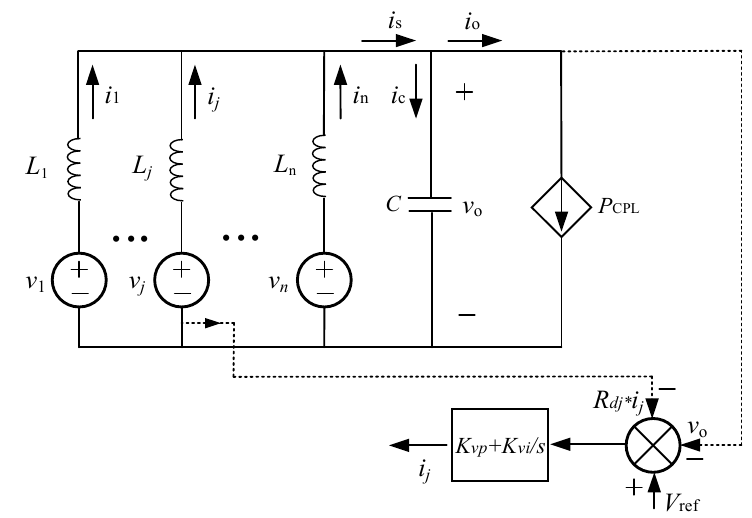
Figure 3. Simplified equivalent diagram of the DC microgrid.